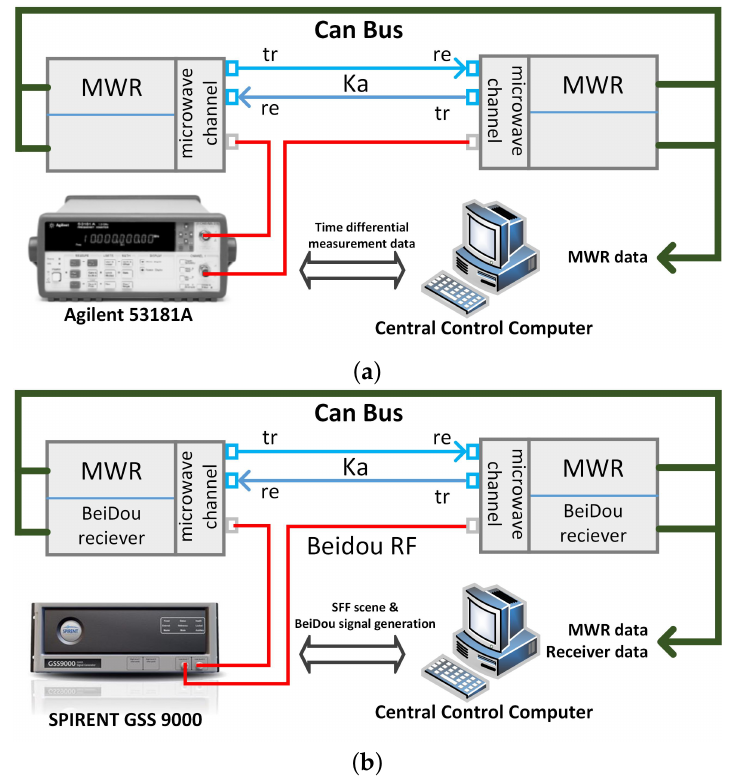
Figure 6. Illustrations of time synchronization test. ( a ) time synchronization test using time interval counter. ( b ) time synchronization test using BeiDou dual frequency